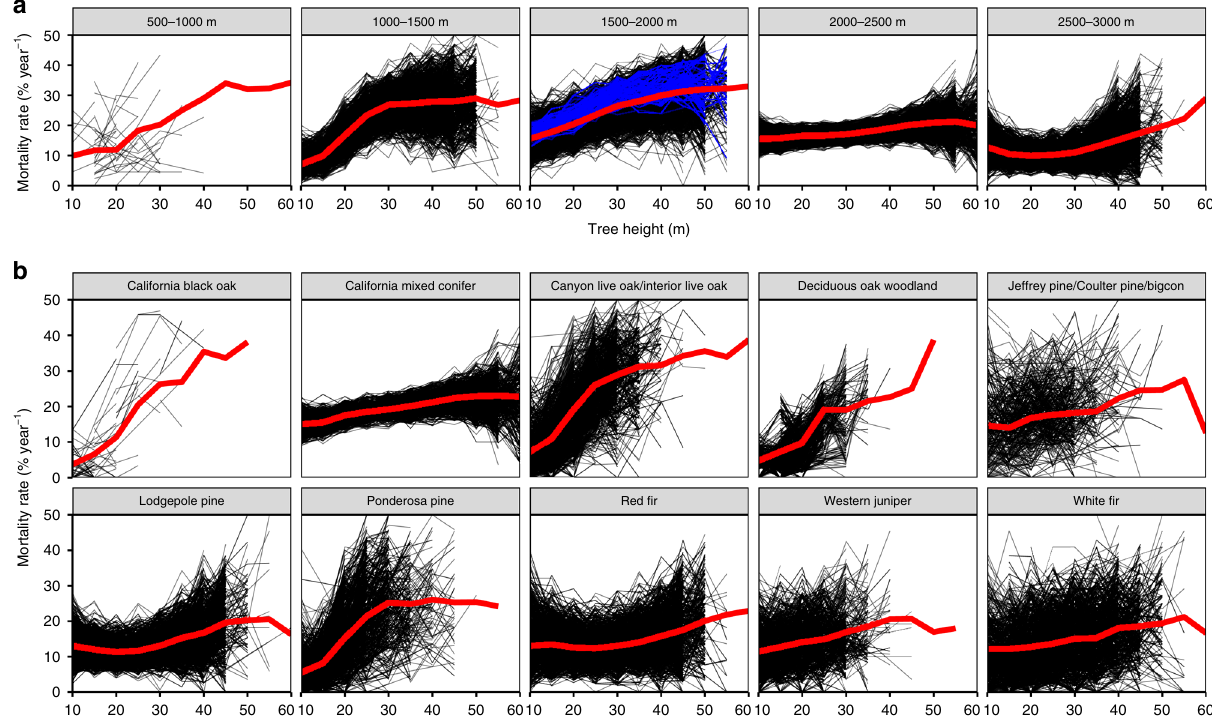
Fig. 2 Simulated fi eld plot sampling shows wide variability in mortality rate estimates. A single plot con fi guration (individual black lines) is statistically unlikely to capture the broad mortality-height trend (red lines) in a unique topographic positions or b forest types. We test 1000 different con fi gurations of 89 0.1-ha plots in the 40,000-ha study area and (blue) a contiguous elevation range identical to Stephenson and Das, fi nding inconsistency in mortality – height trends is primarily due to random variation in plot mortality rates align (~10 – 20% yr − 1 ) between studies. Across 1000 simulations, we found substantial variation ( σ ≈ ±7% yr − 1 ; CV = 52%; Supplementary Fig. 3) in the height – mortality trend due to plot placement and a tendency to underestimate — as opposed to overestimate — mortality rate (5th percentile of errors = − 388%; 95th percentile of errors = 47%). height is likely related to undersampling of the rarest and tallest trees in the forest. How rare are these trees? Our entire dataset of 1.8 million trees covering 40,000-ha of forest, had a mere 17 trees over 70 m tall and, on average, simulated plots sampled only 4 out